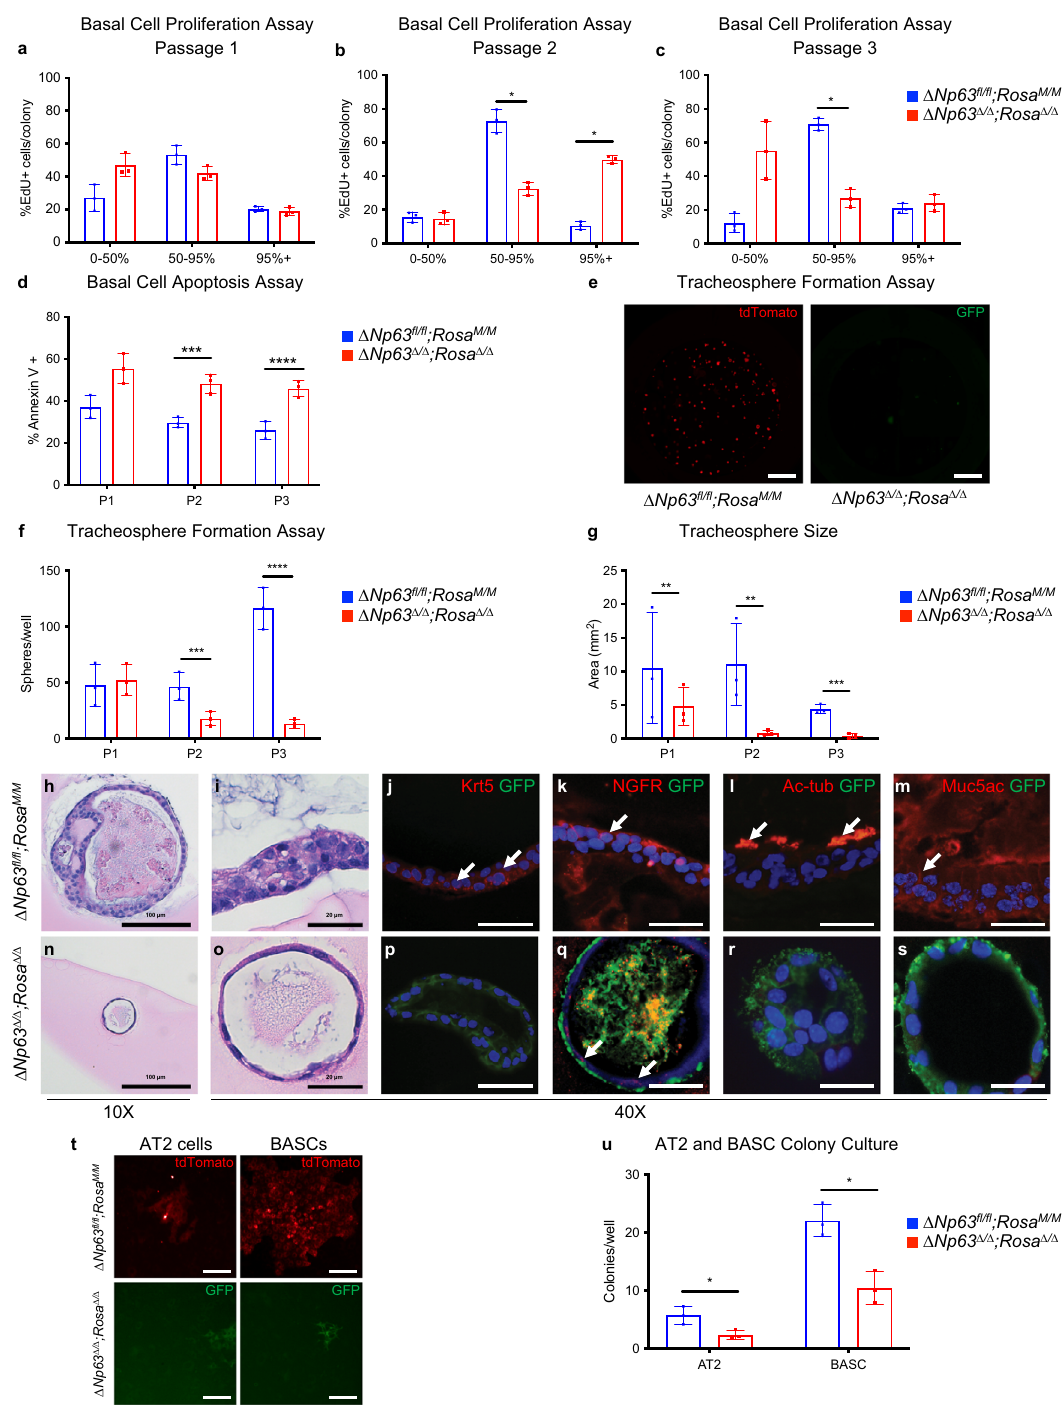
Fig. 4 Δ Np63 is required for self-renewal of basal and distal lung stem cells. a – c Quanti fi cation of EdU incorporation in Δ Np63 fl / fl ; Rosa M/M and Δ Np63 Δ / Δ ; Rosa Δ / Δ colonies at the indicated passages. d Quanti fi cation of Annexin V positive cells the same Δ Np63 fl / fl ; Rosa M/M and Δ Np63 Δ / Δ ; Rosa Δ / Δ colonies shown in ( a – d ). Data were mean±SD, n = 3, * vs. Δ Np63 fl / fl ; Rosa M/M , P <0.05, two-tailed Student ’ s t- test. e Representative wells of tracheosphere formation assay of Δ Np63 fl / fl ; Rosa M/M and Δ Np63 Δ / Δ ; Rosa Δ / Δ basal cells at passage 3. Scale bars equal 250 µ m. f , g Quanti fi cation of number ( f ) and size ( g ) of tracheospheres formed by Δ Np63 fl / fl ; Rosa M/M and Δ Np63 Δ / Δ ; Rosa Δ / Δ basal cells at the indicated passages. Data were mean±SD, n = 3, * vs. Δ Np63 fl / fl ; Rosa M/M , P <0.05, two- tailed Student ’ s t -test. h – s Representative images of tracheospheres in differentiation assay generated from Δ Np63 fl / fl ; Rosa M/M and Δ Np63 Δ / Δ ; Rosa Δ / Δ basal cells, showing H&E stained cross-sections ( h , i and n , o ), and staining for Krt5/GFP ( j and p ), NGFR/GFP ( k and q ), Ac-tub/GFP ( l and r ) and Muc5ac/GFP ( m and s ). t Representative images of colonies formed by Δ Np63 fl / fl ; Rosa M/M and Δ Np63 Δ / Δ ; Rosa Δ / Δ AT2 cells and BASCs. Scale bars equal 50 µ m. u Quanti fi cation of the same colonies as in ( t ). Data were mean±SD, n = 3, * vs. Δ Np63 fl / fl ; Rosa M/M , P <0.05, two-tailed Student ’ s t -test. Source data are provided as a Source Data fi